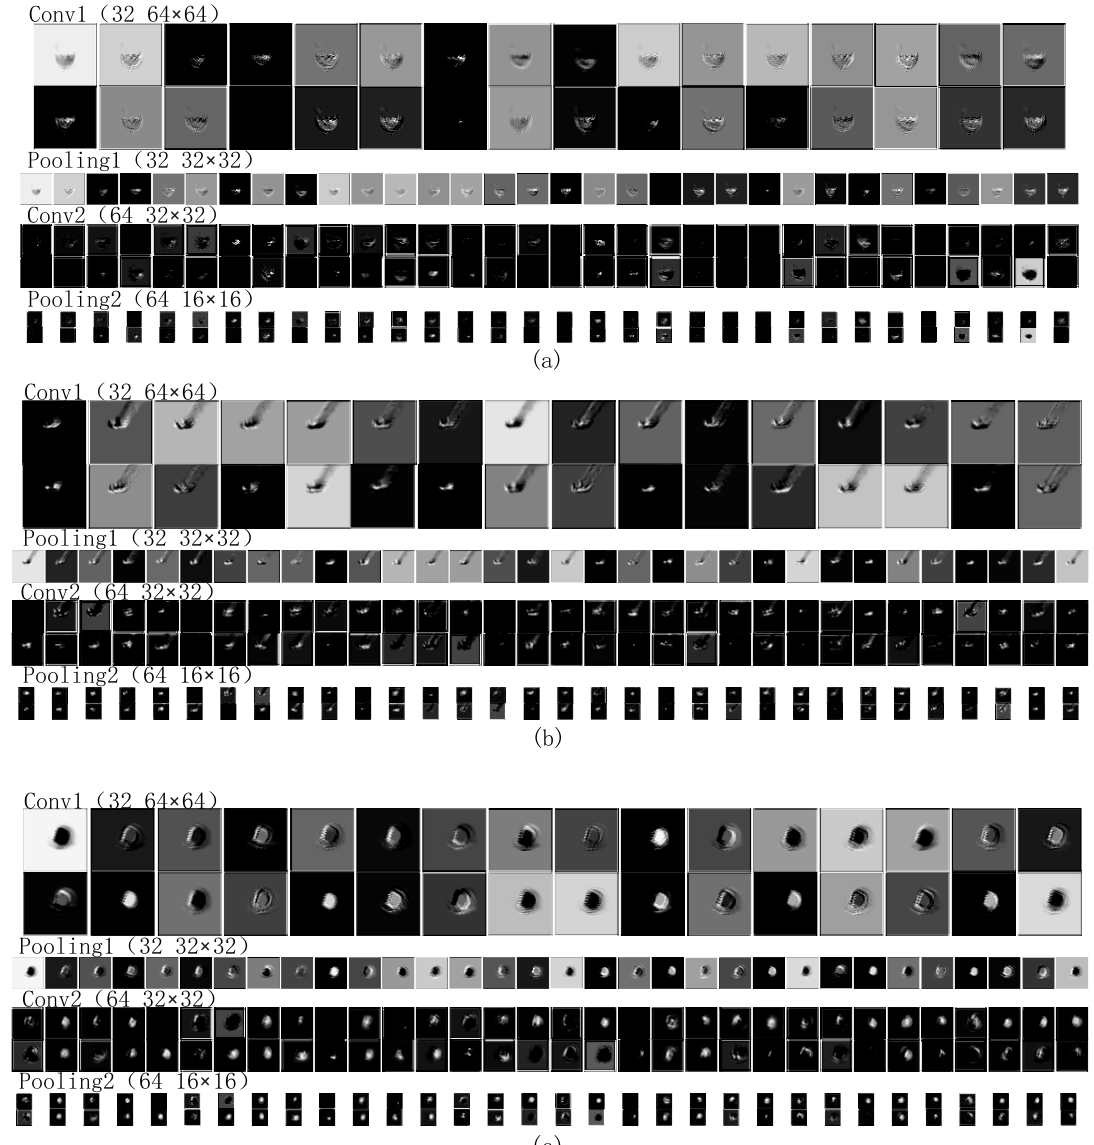
Figure 6. The feature images of the molten pool in three states: ( a ) welding through; ( b ) welding deviation; ( c ) normal welding.